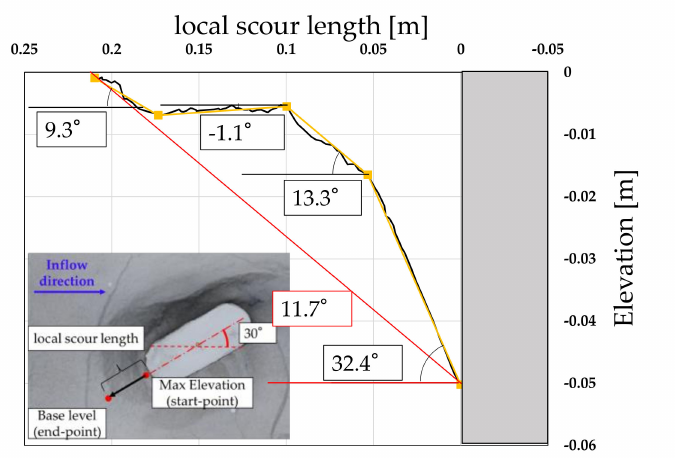
Figure 25. Cross-sectional view of local scour hole in Case 11 ( N = 10: point